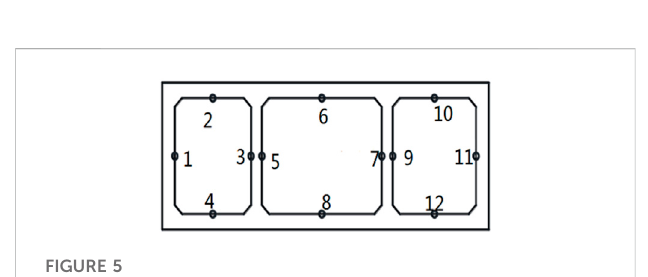
FIGURE 5 Layout of monitoring